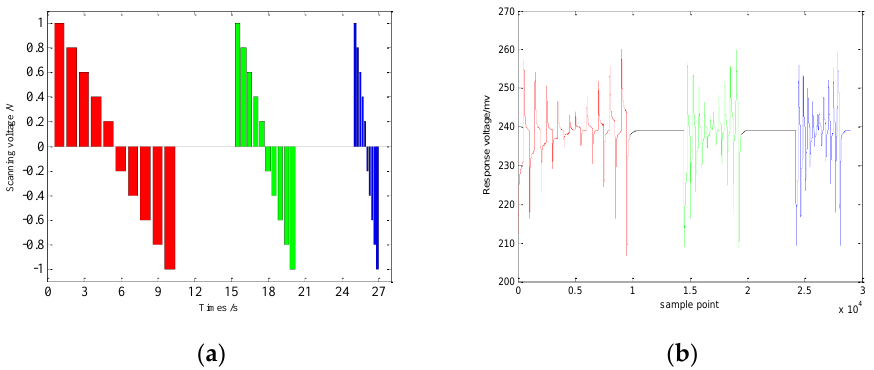
Figure 6. ( a ) The scanning voltage of different frequency; ( b ) typical response of different scanning frequency.